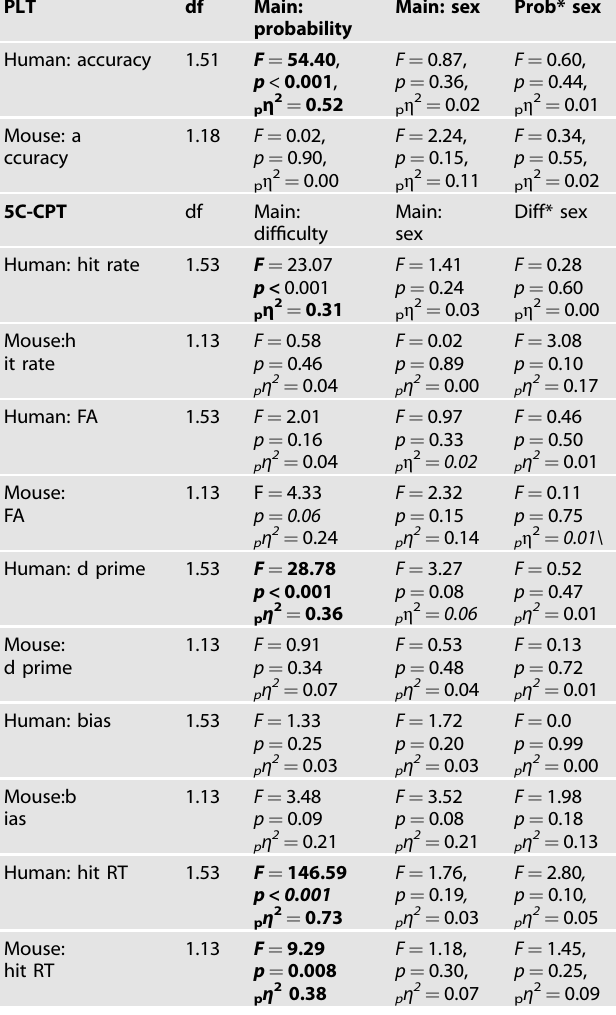
in either the number of trials completed or the breakpoint (human t ’ s < 1, mouse t ’ s < 1.52). Following minimum epoch count requirements, and due to two technical problems in human EEG, there were n = 52 humans ( M = 24, F = 28) and n = 20 mice ( M = 11, F = 9). Both the humans and mice had a signi fi cant late > early alpha power contrast (Table 1). There were no main or interactive effects with sex for either species. Unlike the other experiments in this report, and to the best of our knowledge, the hypothesis of an alpha-band marker of breakpoint-related effort had not been tested. This alpha difference (last minus fi rst) was proposed to scale with greater 41 motivation loss, and it was indeed negatively correlated with the 82 . breakpoint in humans ( ρ (52) = − 0.28, p = 0.046; Supplemental Figure S2). Notably, time-on-task, as measured by the number of seconds on the PRBT did not correlate with breakpoint (rho(52) = − 0.15, p = 0.30). This outcome highlights the fact that participants achieved a higher breakpoint through effort, which correlated with alpha-band difference, not time. A stepwise regression veri fi ed this speci fi c relationship, where seconds did not correlate with the alpha difference ( F < 1), yet the addition of the breakpoint b in the next level led to a signi fi cant F change ( F (2,49) = 4.03, T a